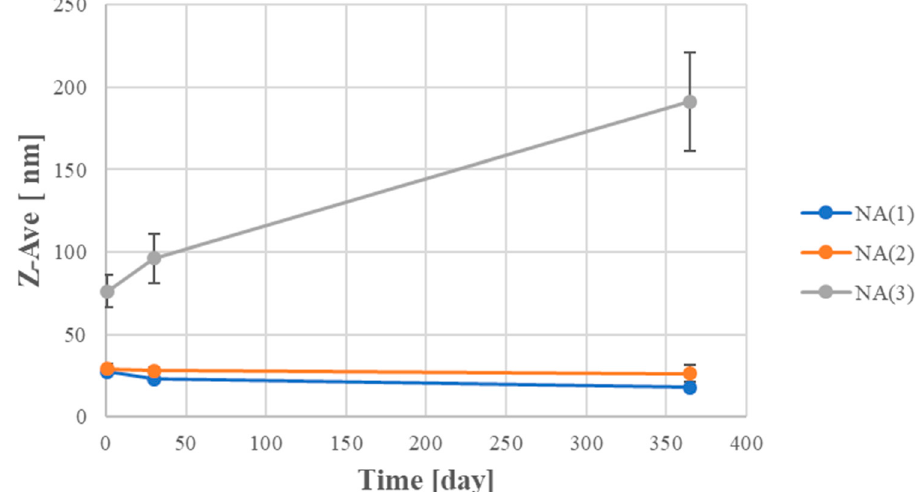
Figure 2. Particle size distribution over time for nanoemulsions based on fragrance A with different mass ratios of the surfactant:oil (NA(1) = 0.625:0.374; NA(2) = 0.5:0.5; NA(3) = 0.4:0.6) (SD, n =3).